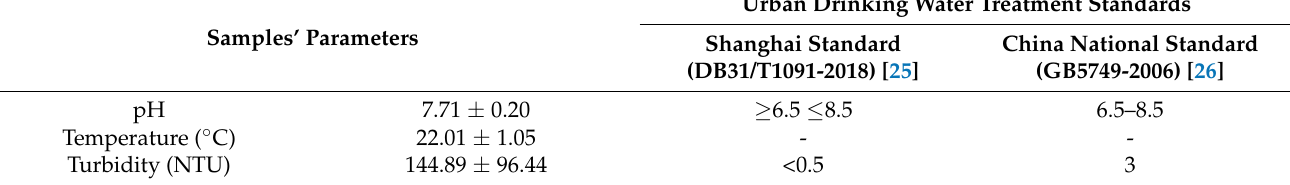
Table 1. Characteristics of raw water from the Yangtze River (values are means ± standard deviation, where n =